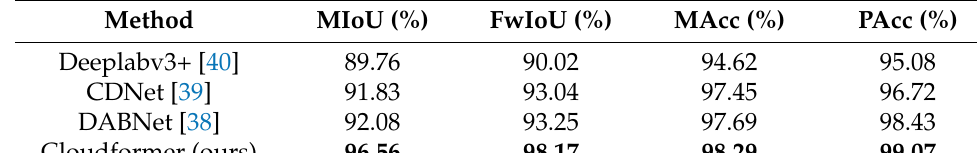
Table 4. Comparison of different cloud-detection methods on AIR-CD.